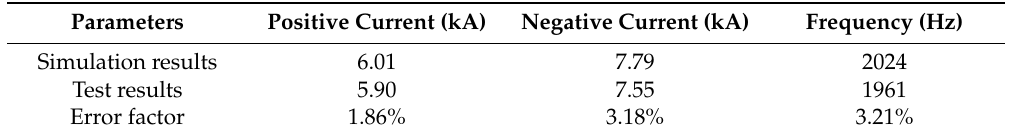
Table 1. The test and simulation results.